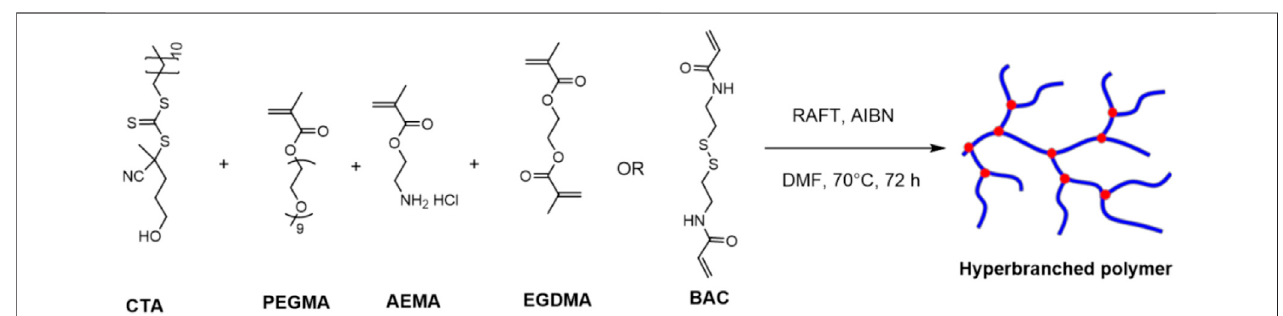
FIGURE 5 | Radical polymerization to form hyperbranched polymers (Marasini et al., 2020).